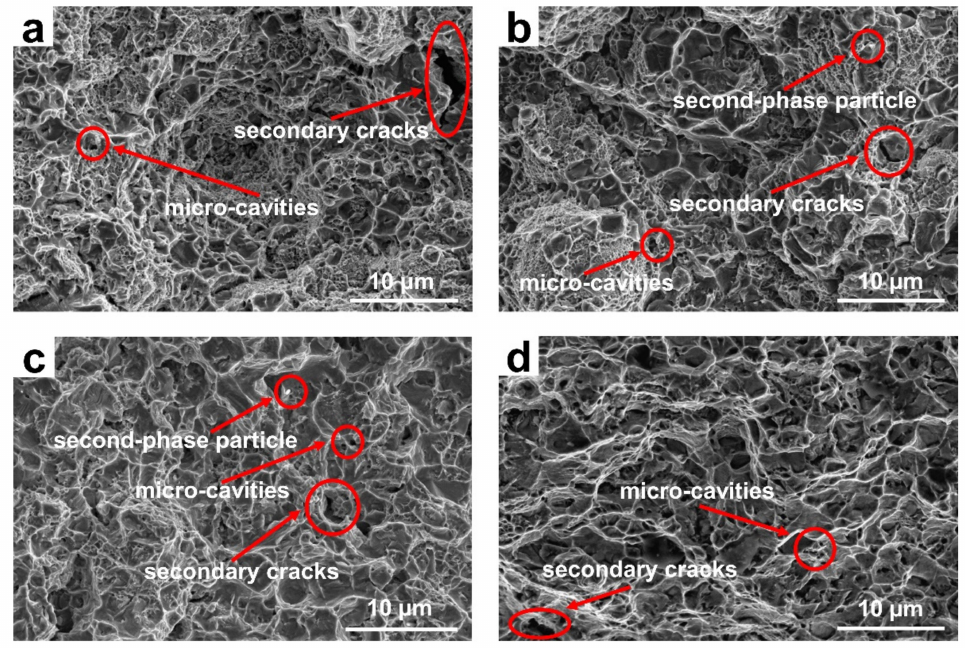
Figure 6. SEM images of tensile fractures of the as-sintered alloys. ( a ) SS and alloys treated with different cooling rates: ( b ) FC; ( c ) AC; ( d )